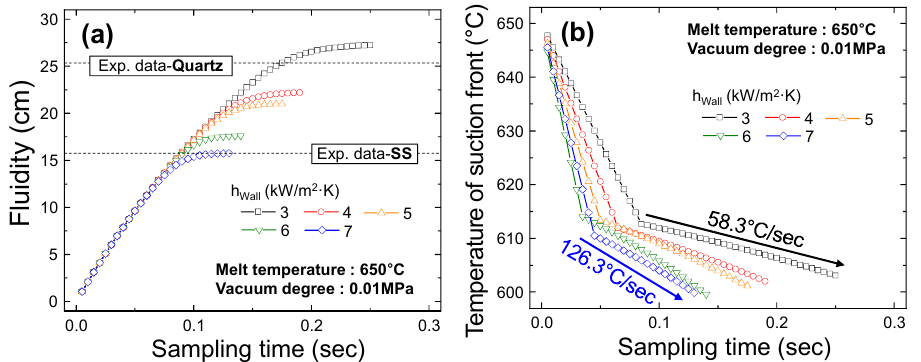
Figure 8. Calculation results of the present fluidity model with different heat transfer coefficients: ( a ) fluidity length and ( b ) temperature change at the suction front of the fluidity